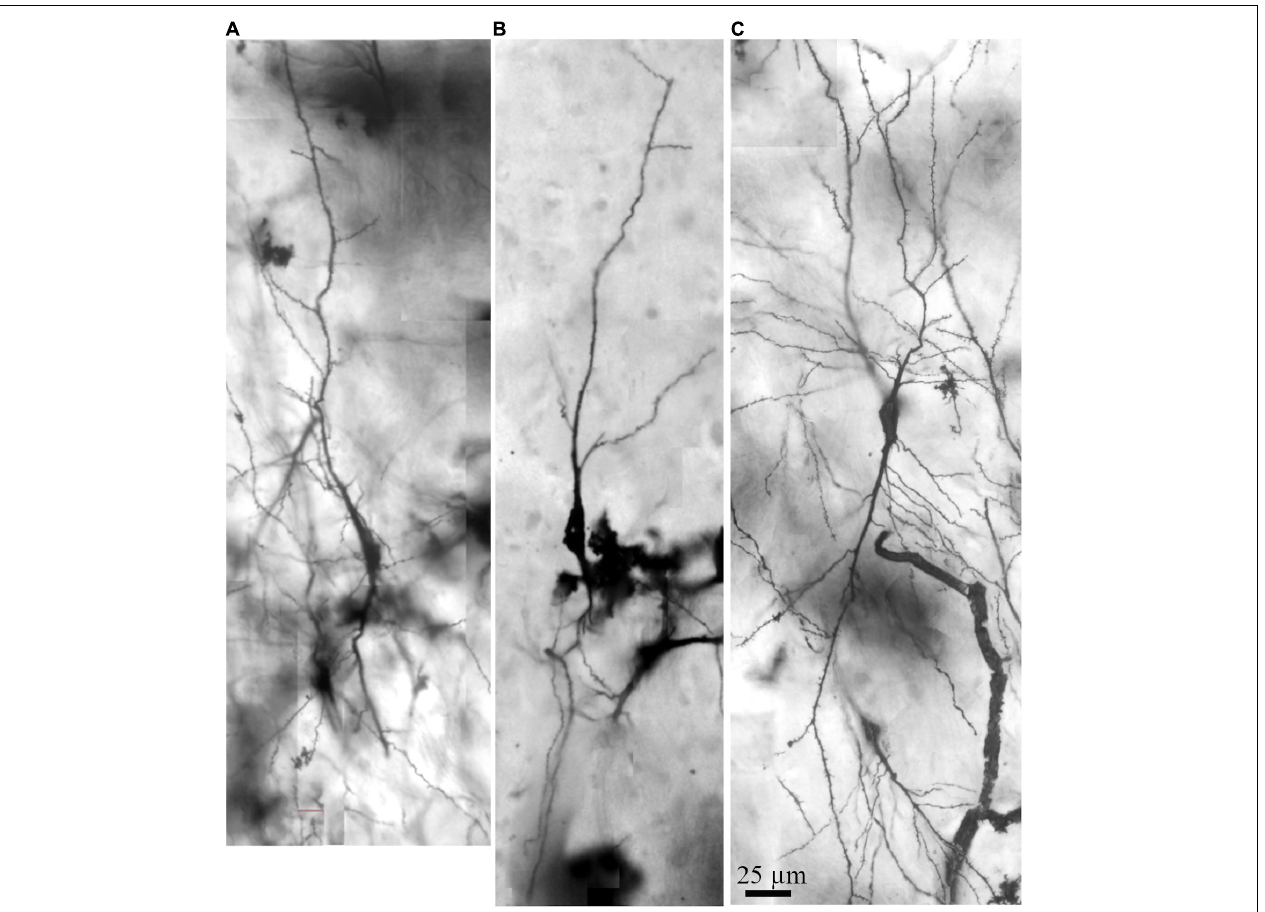
FIGURE 4 | Photomicrographic composition of Golgi-impregnated spindle-shaped neurons from layer V and in the transition to layer VI in the human precuneus observed using brightfield microscopy. (A–C) Neurons show a spindle-shaped soma with vertically oriented main primary dendritic shafts at opposite poles and the dendritic ramification in one focal plane. These neurons were 2D and 3D reconstructed and are shown in Figures 5–8 and Supplementary Figures 1–3 . Dendritic spines are not quite visible at this magnification. Image adjustment of contrast and brightness made with Photoshop CS3 (Adobe Systems, Inc., United States).